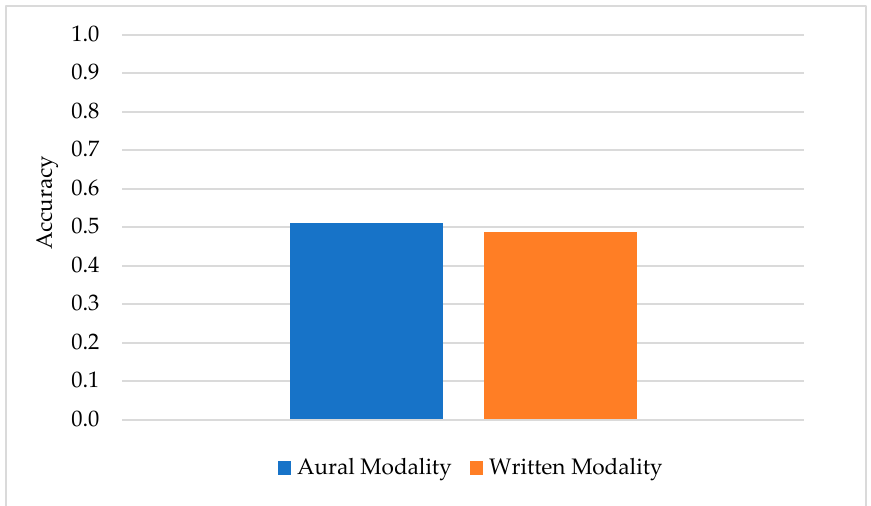
Figure 6. PMT: L2 learners’ mean accuracy on comprehension of passive clauses by modality.